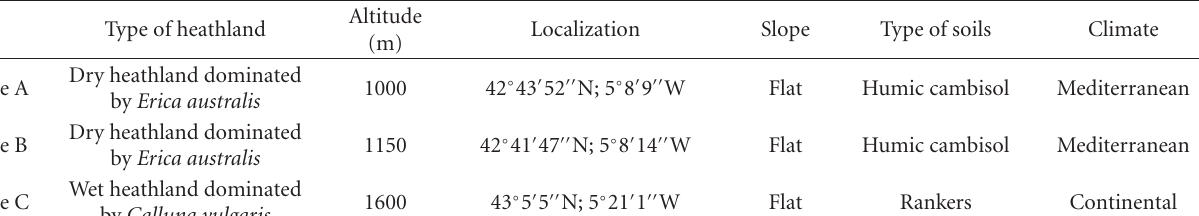
Table 1: Characteristics of the three study zones.